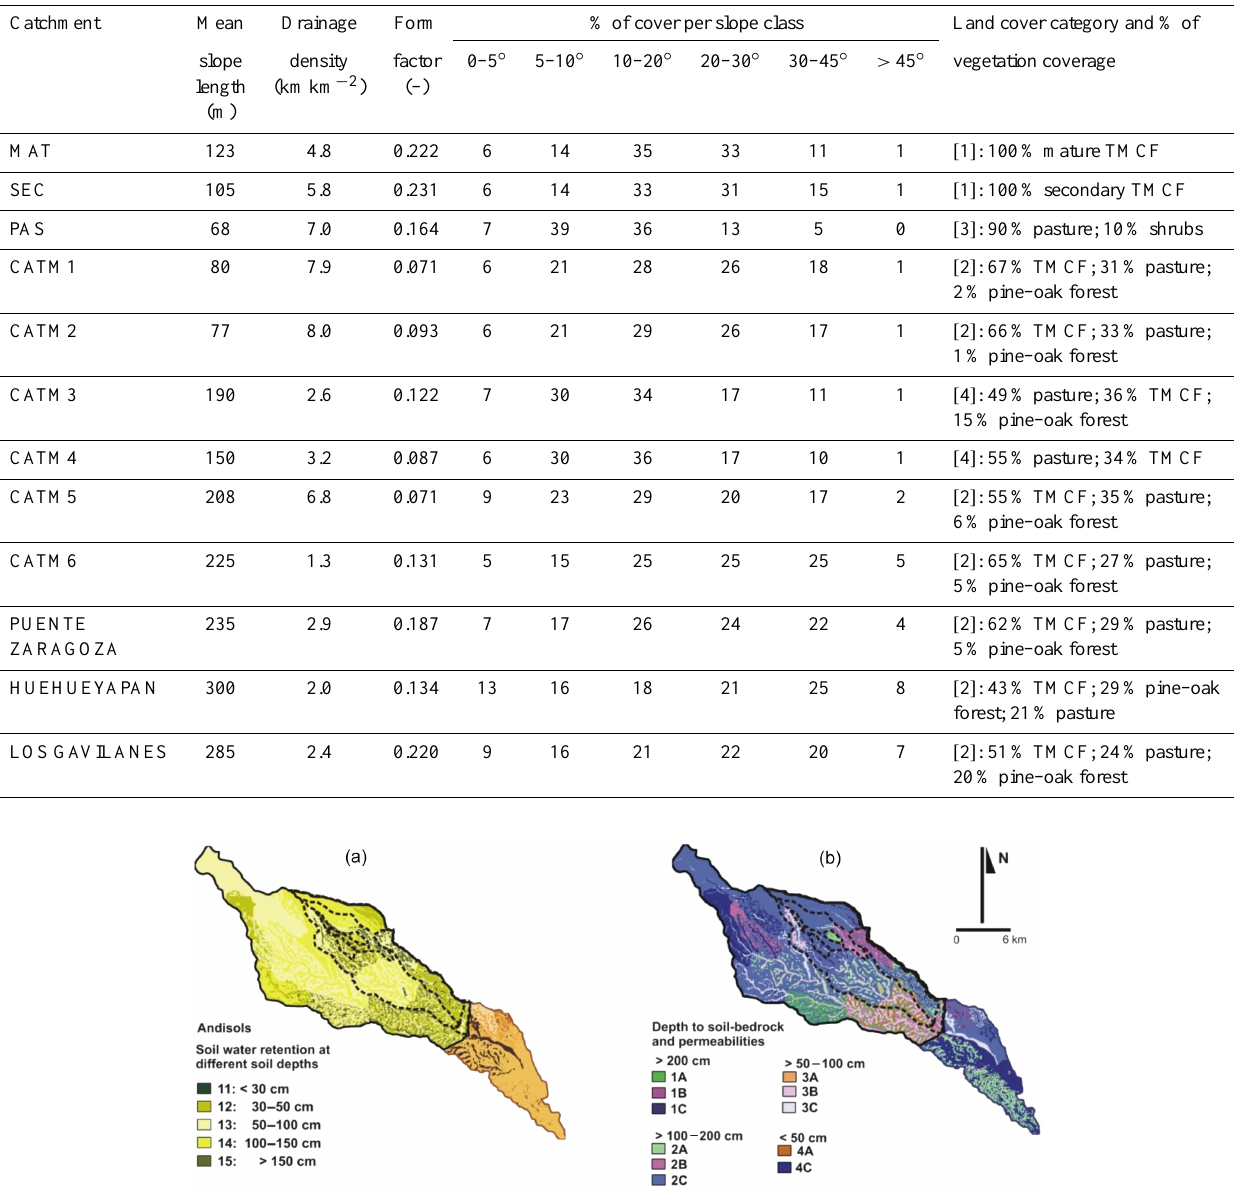
Table 3. Slope length and gradient, drainage density, form factor, and land cover of the study catchments. Catchment